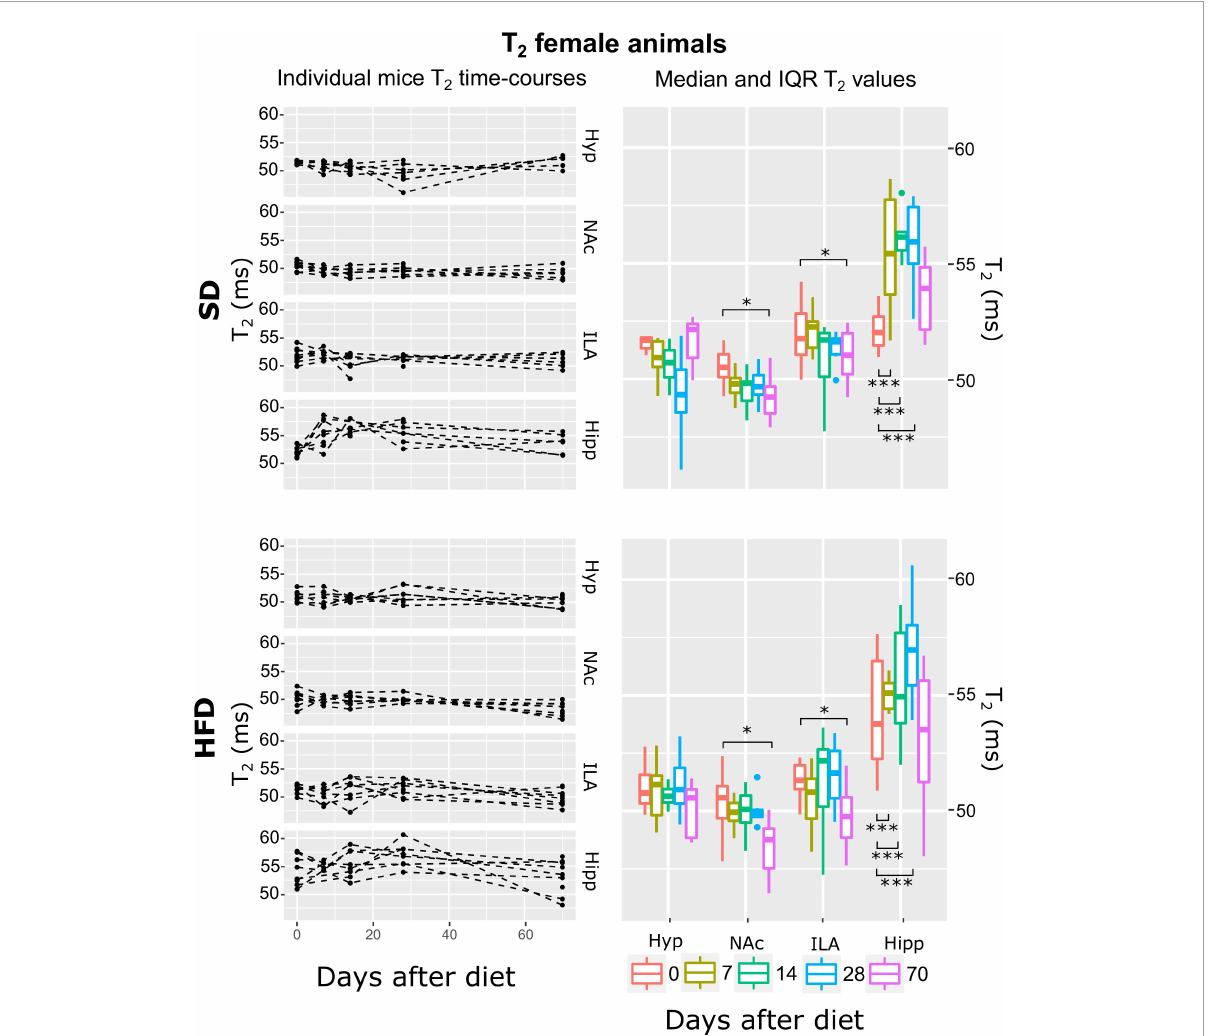
FIGURE8 T2 changes on female mice during HFD or SD consumption. T2 changes on SD-fed (top panels) or HFD (bottom panels) female mice in the four regions investigated: hypothalamus (Hyp), nucleus accumbens (NAc), ipsilateral area (ILA) and hippocampus (Hipp) at all time points measured. Left panels depict the individual T2 regional values at each time point, with dashed lines connecting the adjacent points. Right panels illustrate box plots of T2 vs. time-point for the 4 areas, with each color representing the specific time-point, as days after diet diversification. Note how T2 behaves similarly under both diets, with decreasing values on the NA0c and ILA, and increasing on the hippocampus (* p < 0.05, *** p <